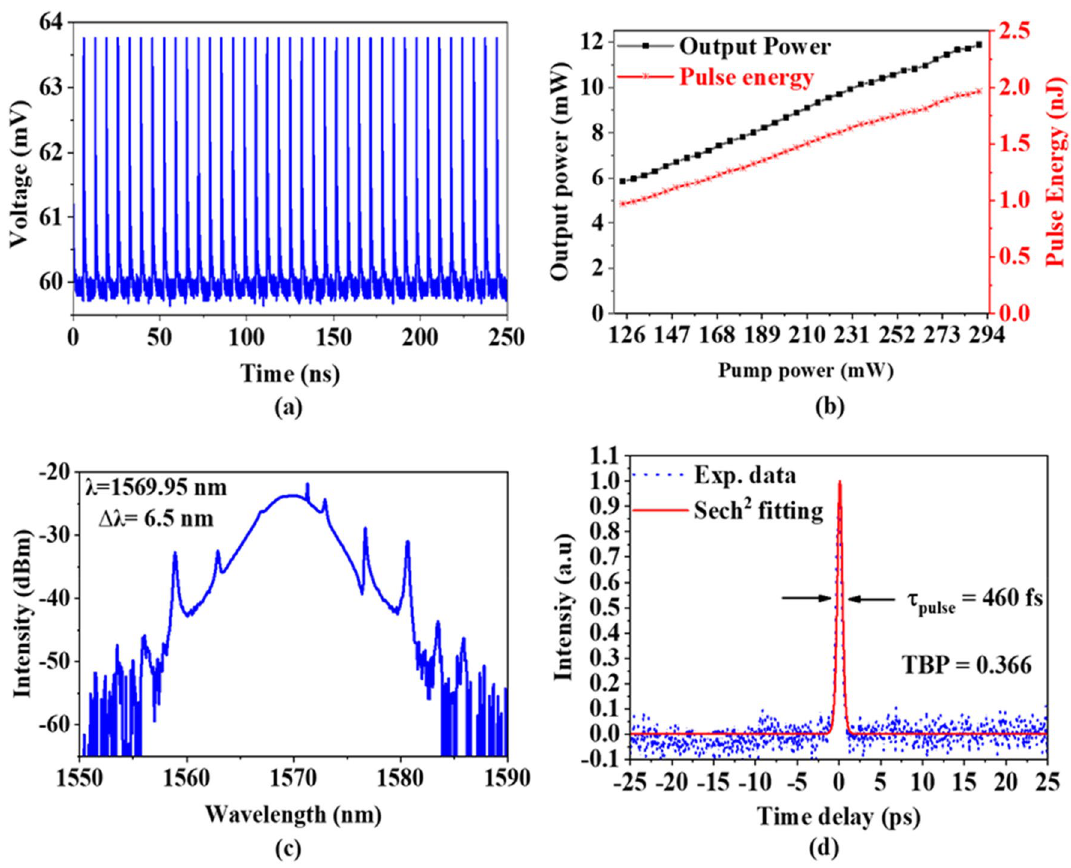
Figure 8. Spectral and temporal properties of the soliton pulse with 33.7 m cavity length ( a ) typical pulse train, ( b ) Pulse energy and output power changing with pump power ( c ) laser wavelength ( d ) autocorrelator started soliton pulse was successfully produced at the threshold pump power of 124 mW. The laser operated at a constant pulse repetition rate of 6.049 MHz between pump power of 124 to 290 mW. Figure 8a illustrations a typical pulse train at pump power of 290 mW, indicating an identical mode-locked pulse train with no significant instabilities nor distortion. The pulse period is about 165.3 ns, which corresponds to the cavity length and repeti- tion rate. The pulse energy and average output power were increased linearly with the increase of pump power, as recorded in Fig. 8b. At the maximum pump power of 290 mW, the pulse energy and average output power are measured to be 1.96 nJ and 11.89 mW, respectively. Figure 8c presents the output optical spectrum at the pump power of 290 mW. The laser operated as soliton spectrum at a central wavelength of 1569.95 nm with a 3 dB bandwidth of 6.5 nm. The mode-locked EDFL oper- ated at anomalous cavity dispersion and proved by Kelly sidebands 43 . The laser wavelength demonstrated sym- metrical Kelly sidebands with a distance to the central wavelengths of 2.9, 6.9, and 10.9 nm for the first, second, and third - order, respectively. The distance is related to the pulse duration, operating wavelength, and total net dispersion 44 . Figure 8d shows the autocorrelation trace with sech 2 fitting which has a pulse width of 460 fs. The TBP is 0.363 which is closing to the transform-limited value of 0.315, indicating the pulse is slightly chirped. The RF output spectrum was recorded as shown in Fig. 9a. The fundamental frequency of the laser (6.049 MHz) has a very good signal-to-noise ratio (SNR) of ~ 75 dB, which further verified the stability of the laser. The long-term evaluation of laser operation is presented in Fig. 9b. The mode-locked EDFL operated stably peak intensity of spectrum were kept at 1569.95 nm, 6.5 nm, and − 23.69 dBm, respectively. All experiments generated stable pulse trains with excellent performance for the development of high-power